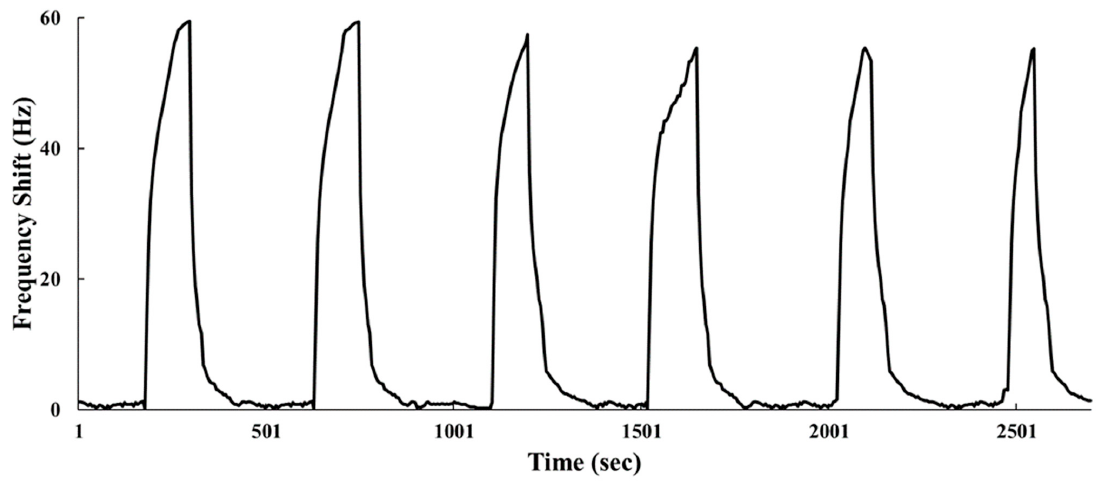
Figure 8. Dynamic responses of a SAW sensor to 750 ppb NH 3 for six consecutive cycles.